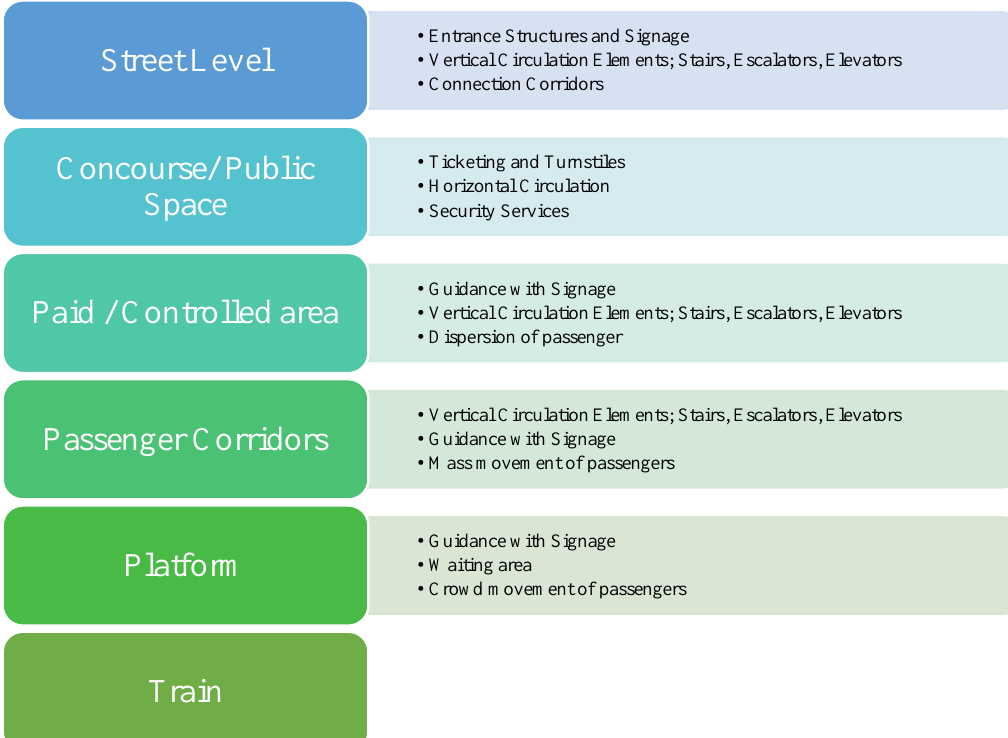
Figure 2 An example of a pedestrian flow in subway station case study showing the movement scheme of pedestrians in a subway station with stations zones stacked in order from the surface to the train along with the movement factors and assistants in the process (author)